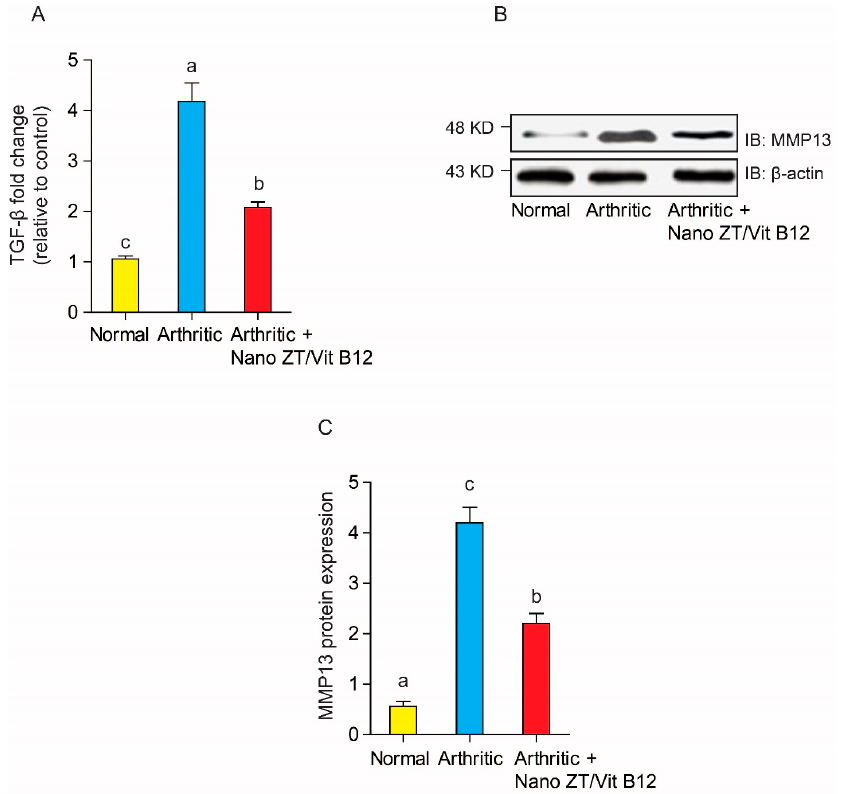
Figure 11. Effects of Nano ZT/Vit B12 on TGF- β mRNA expression and MMP13 protein levels. Data are presented as mean ± SEM; the values for each parameter indicated with a different superscript alphabet (s) ( A , B , and C ) are significantly different ( p < 0.05). When sections of the right ankle joint of the hind leg of normal control rats were stained with H&E, there was no inflammation. The synovium of rats with CFA-induced arthritis, on the other hand, showed hyperplasia as well as significant infiltration of in- flammatory cells and extensive cartilage deterioration, while rats given Nano ZT/Vit B12 had nearly normal articular surfaces and synovial membranes with no signs of inflamma- tion (Figure 12). In addition, Table 2 shows the histological lesion scores of the joint dam- age.